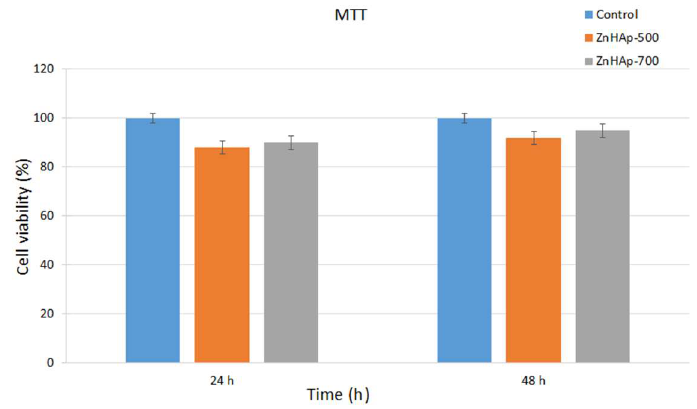
Figure 8. Cell viability of the HeLa cells for incubation times of 24 and 48 h in the presence of ZnHAp-500 and ZnHAp-700 layers.